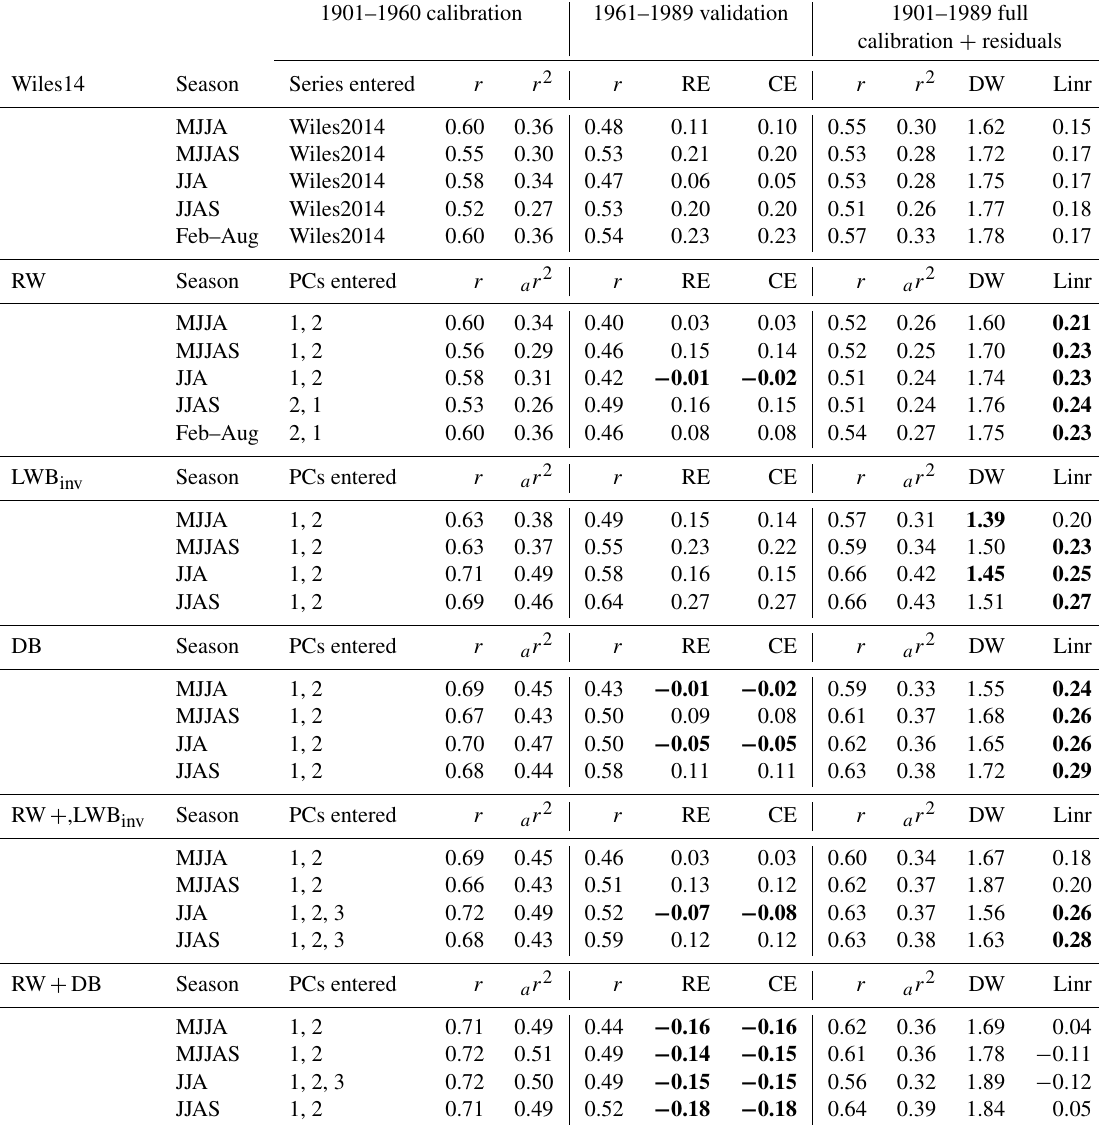
Table 4. Calibration experiments for the four strongest seasons (see Fig. 2). Initial calibration (using CRU TS 3.24) was made over 1901–1960 and validation over 1961–1989. Full calibration (1901–1989) was also performed to allow for residual tests and extra validation using BEST (1850–1990; see Fig. 2). Results in bold font do not pass significance. r : Pearson’s correlation coefficient; r 2 : coefficient of determination; 2 : r 2 adjusted for the number of predictors in the model; RE: reduction of error; CE: coefficient of efficiency; DW: Durbin–Watson test a r for residual autocorrelation; LINr: linear trend in the